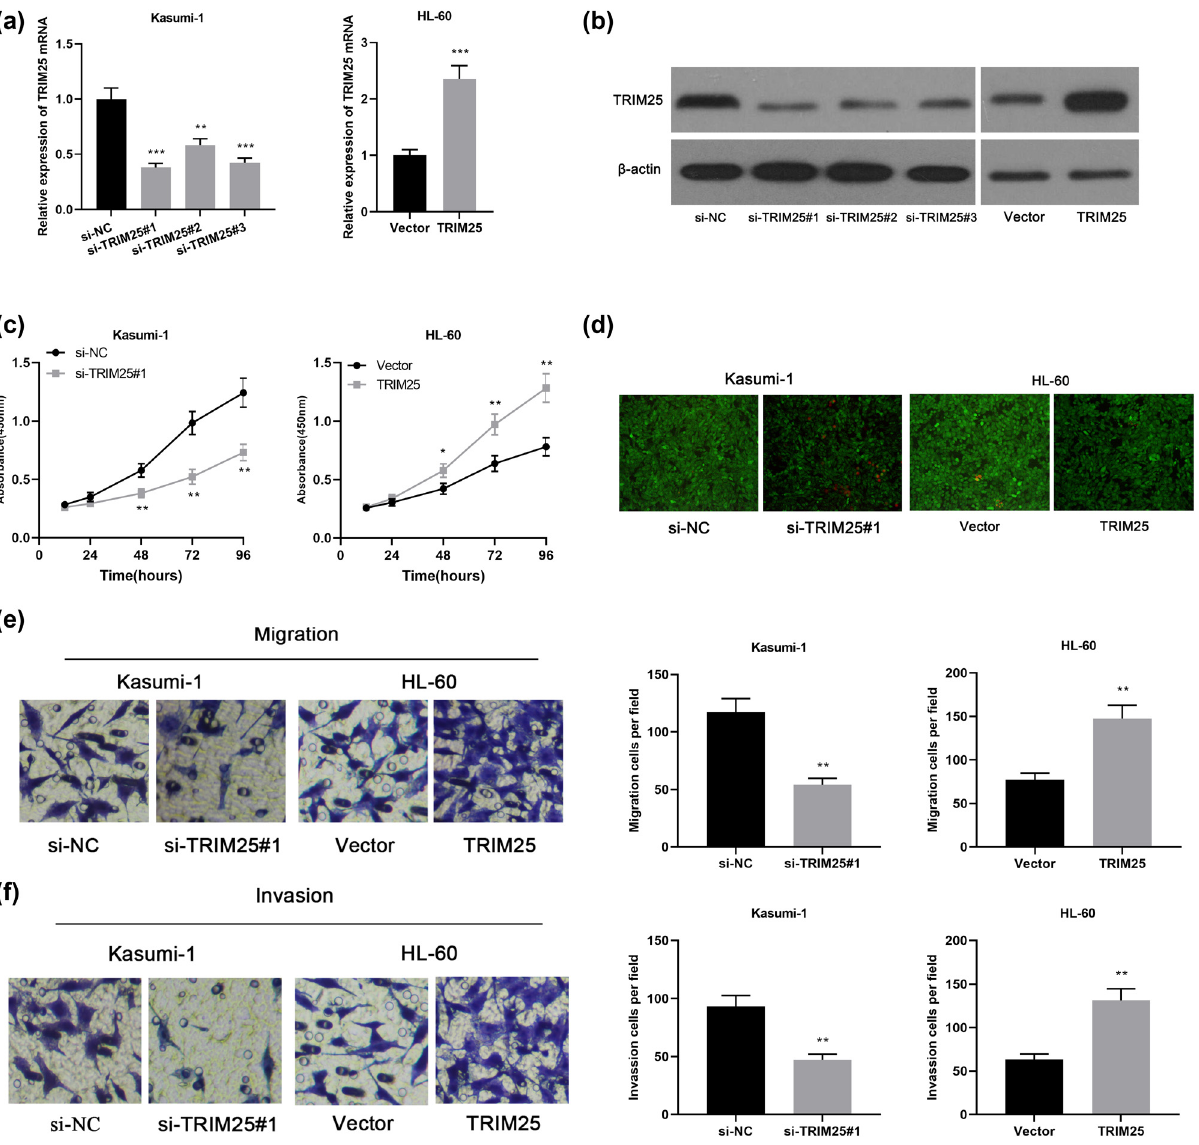
Figure 2: TRIM25 promoted the proliferation, migration, and invasion of AML cells. ( a ) qPCR to detect TRIM25 mRNA expression in Kasumi - 1 and HL - 60 cells after knocking down or overexpressing TRIM25. ( b ) Western blot analysis of TRIM25 protein expression in cells transfected with miR - 137 mimics or inhibitor. ( c ) CCK - 8 assay to detect the proliferation of AML cells after knocking down or overexpressing TRIM25. ( d ) Cell viability was tested using live ( calcein staining, green ) /dead ( PI staining, red ) assay. Scale bar = 100 µm. ( e and f ) . Transwell test to detect the migration and invasion of AML cells after knocking down or overexpressing TRIM25. * P < 0.05, ** P < 0.01, *** P <